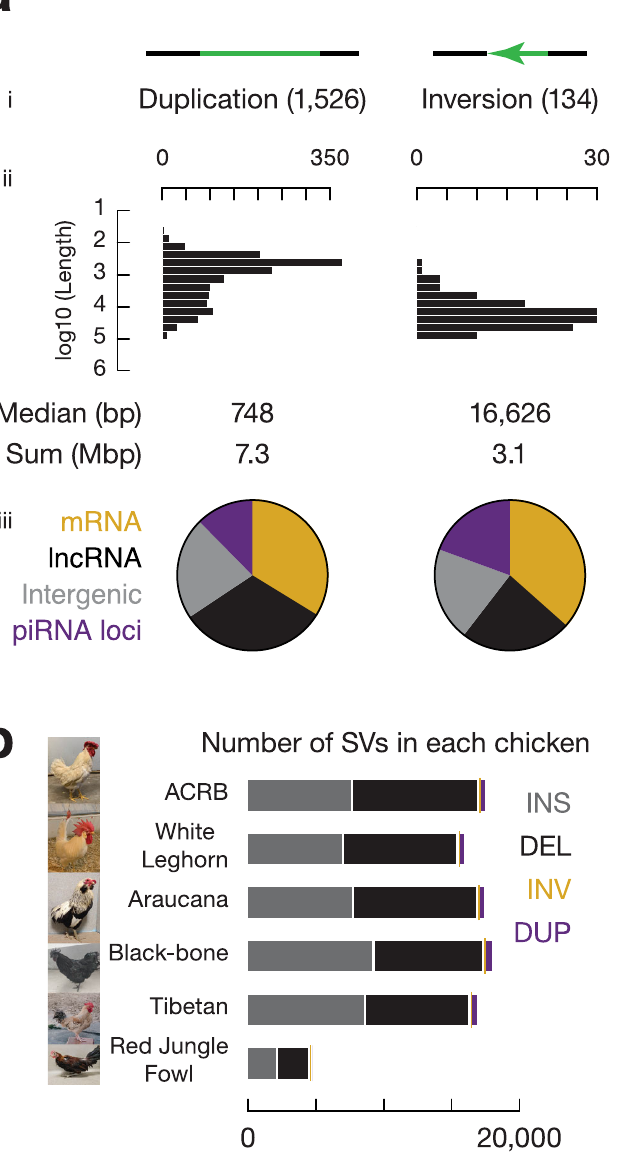
Fowl is from the same population selected for reference genome sequencing, the 4934 SVs detected in Red Jungle Fowl likely underrepresented the level of genetic diversity in the wild chicken population. c The number of SVs (red) and randomly shuf fl ed control sequences (purple) falling into the piRNA loci ( n =1321). Violin plots represent the randomly shuf fl ed control sequences that were computed 10,000